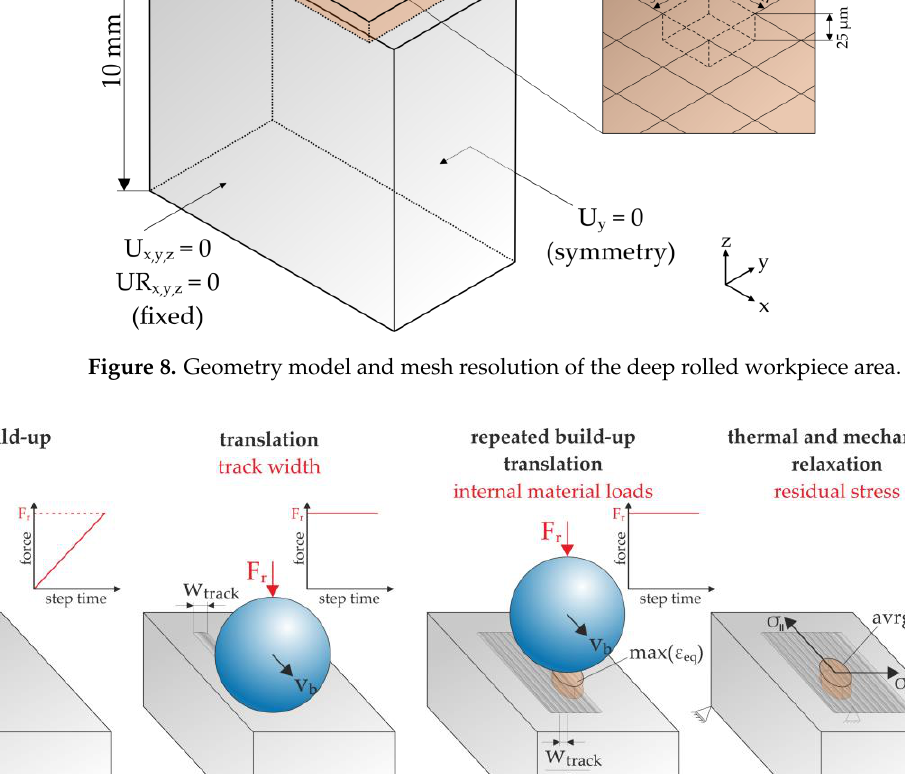
Figure 8. Geometry model and mesh resolution of the deep rolled workpiece area.